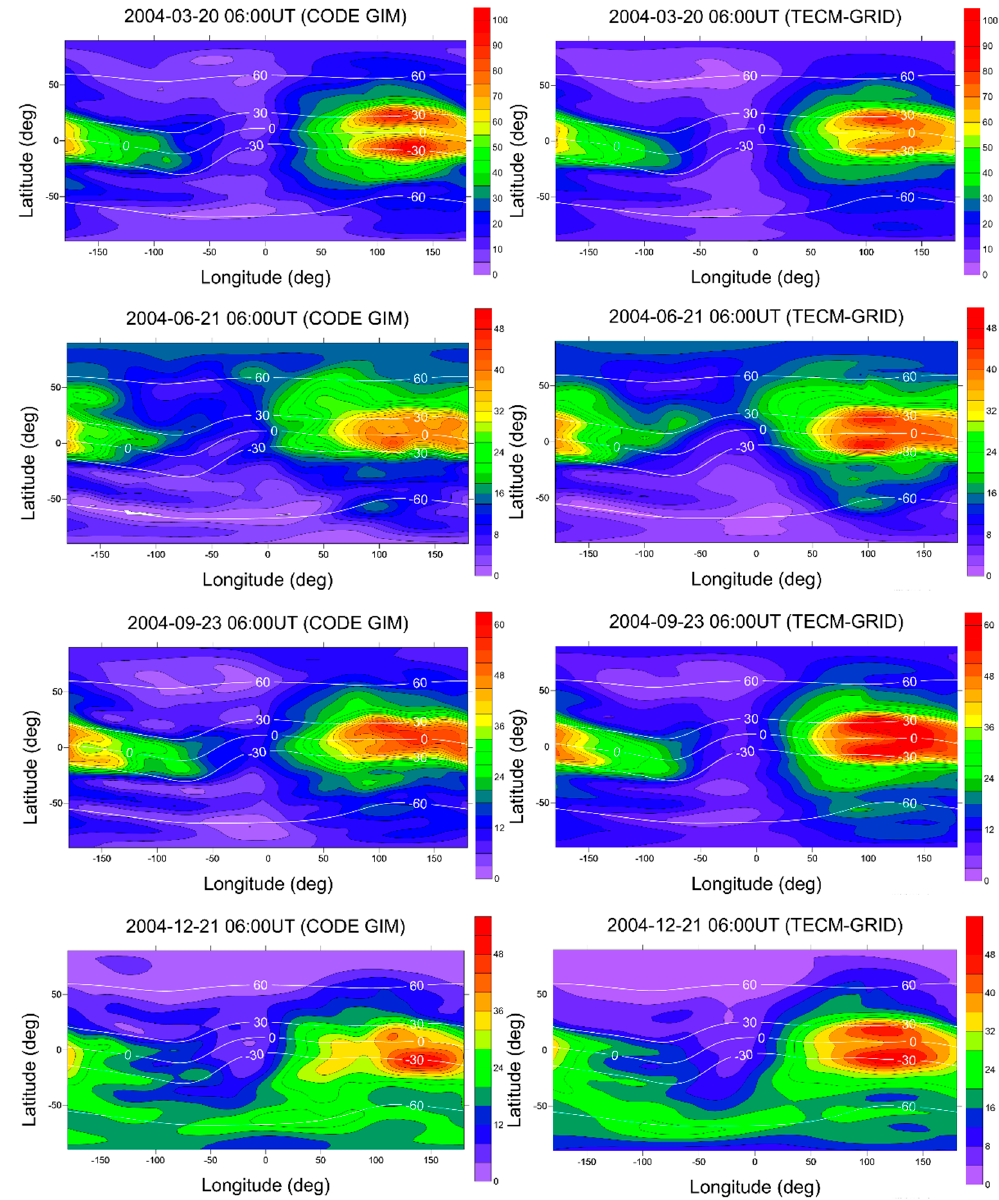
Figure 5. Comparison of CODE GIMs and TECM-GRID models (2004).